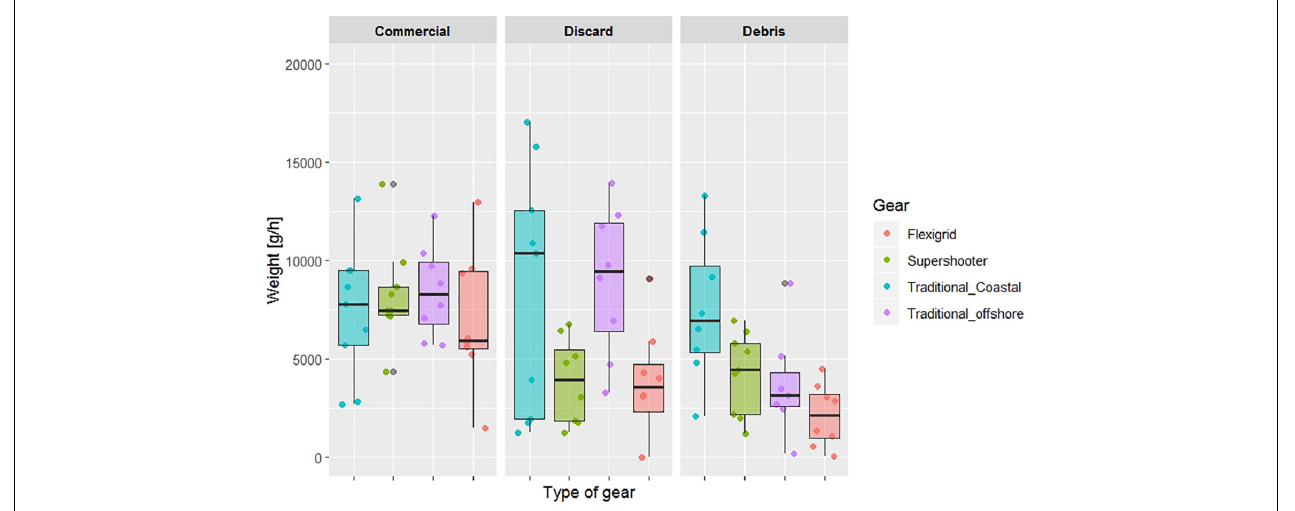
FIGURE 3 | Box plot of the mean catches (g · h − 1 ) and standard deviations of the different categories (Commercial, Debris, and Discards) obtained with the different tested nets.